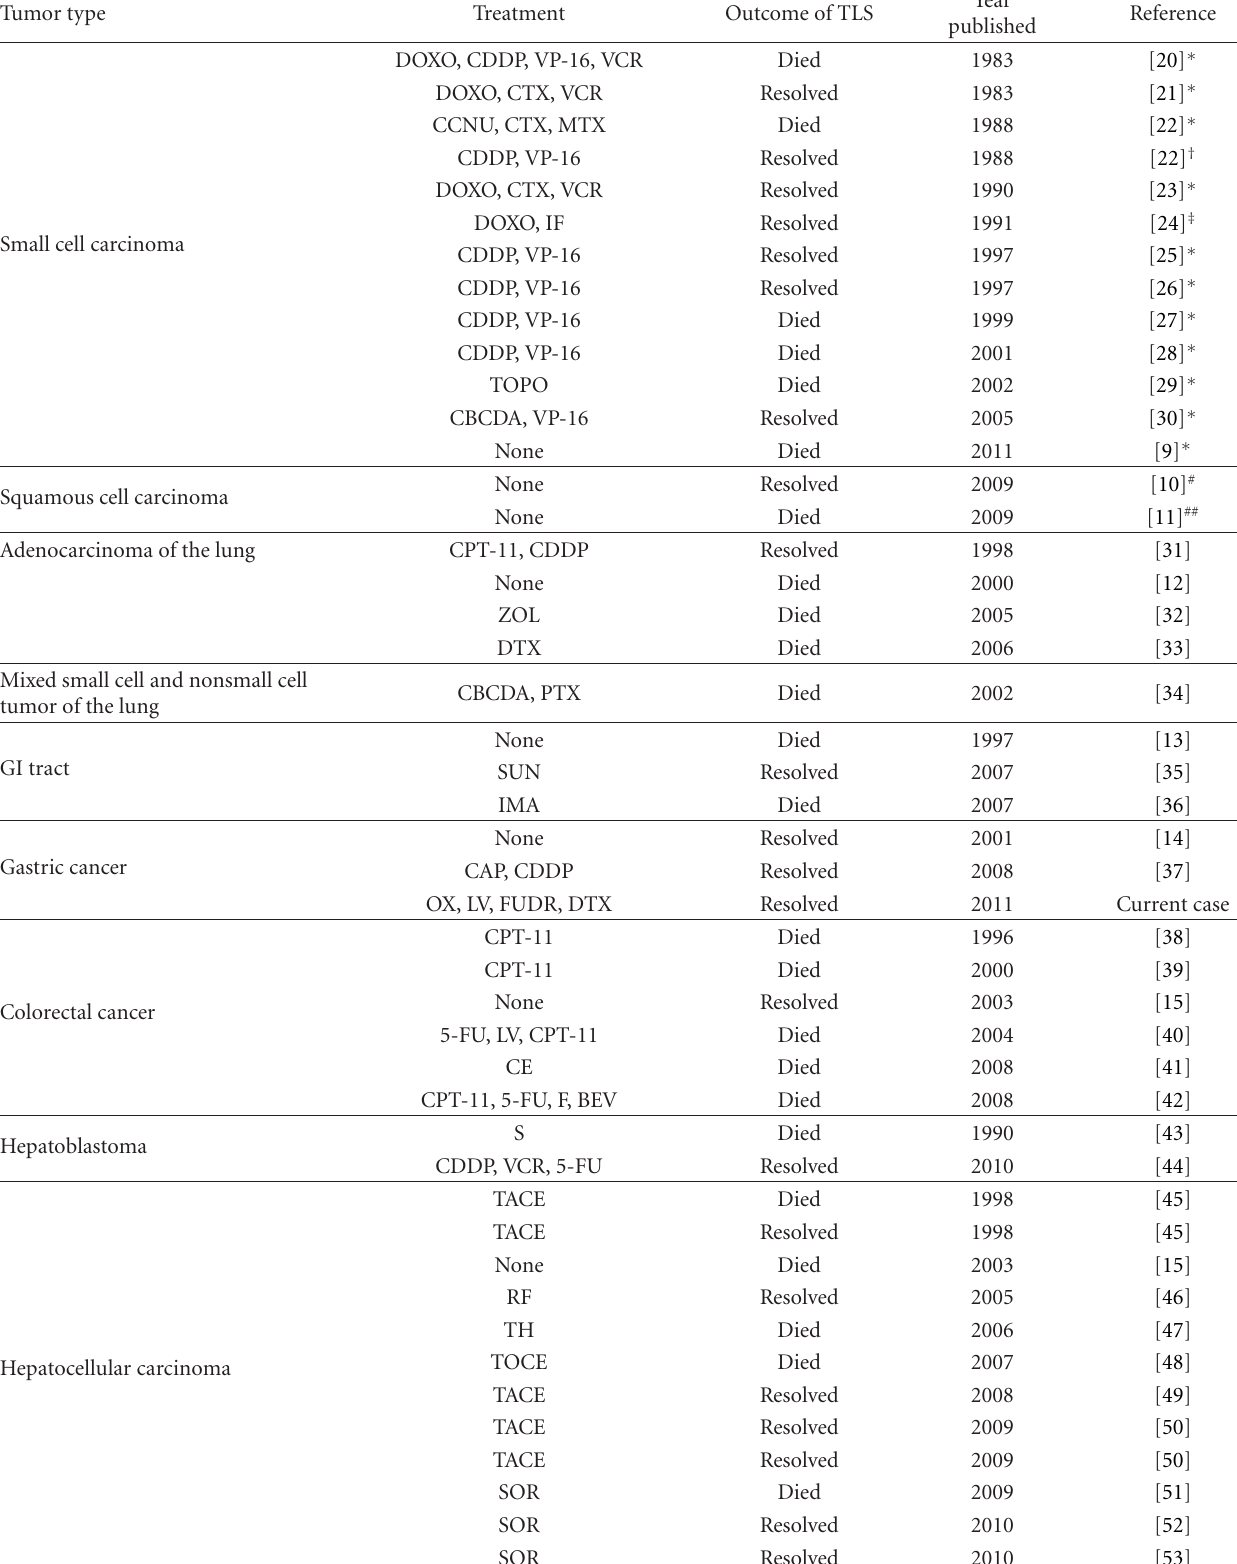
Table 1: Reported cases of tumor lysis syndrome in solid tumors